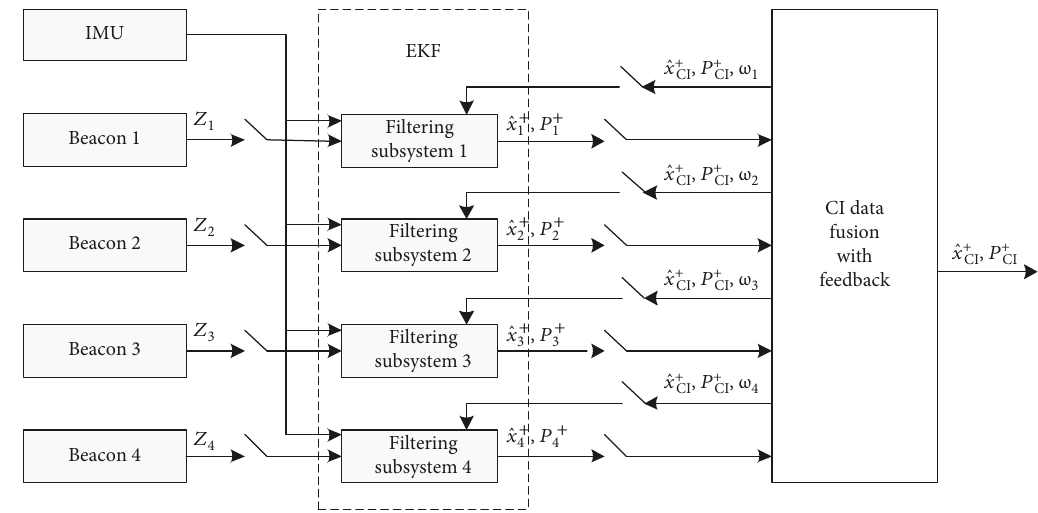
Figure 4: CI fusion algorithm with information feedback for four local fi lters. Table 1: Initial condition for integrated navigation.